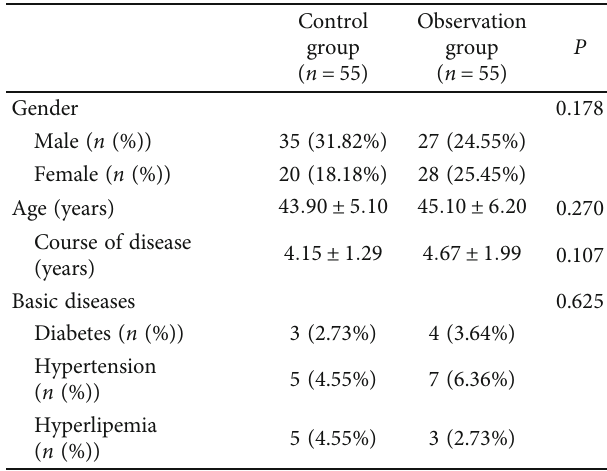
Table 2: Baseline data of the two